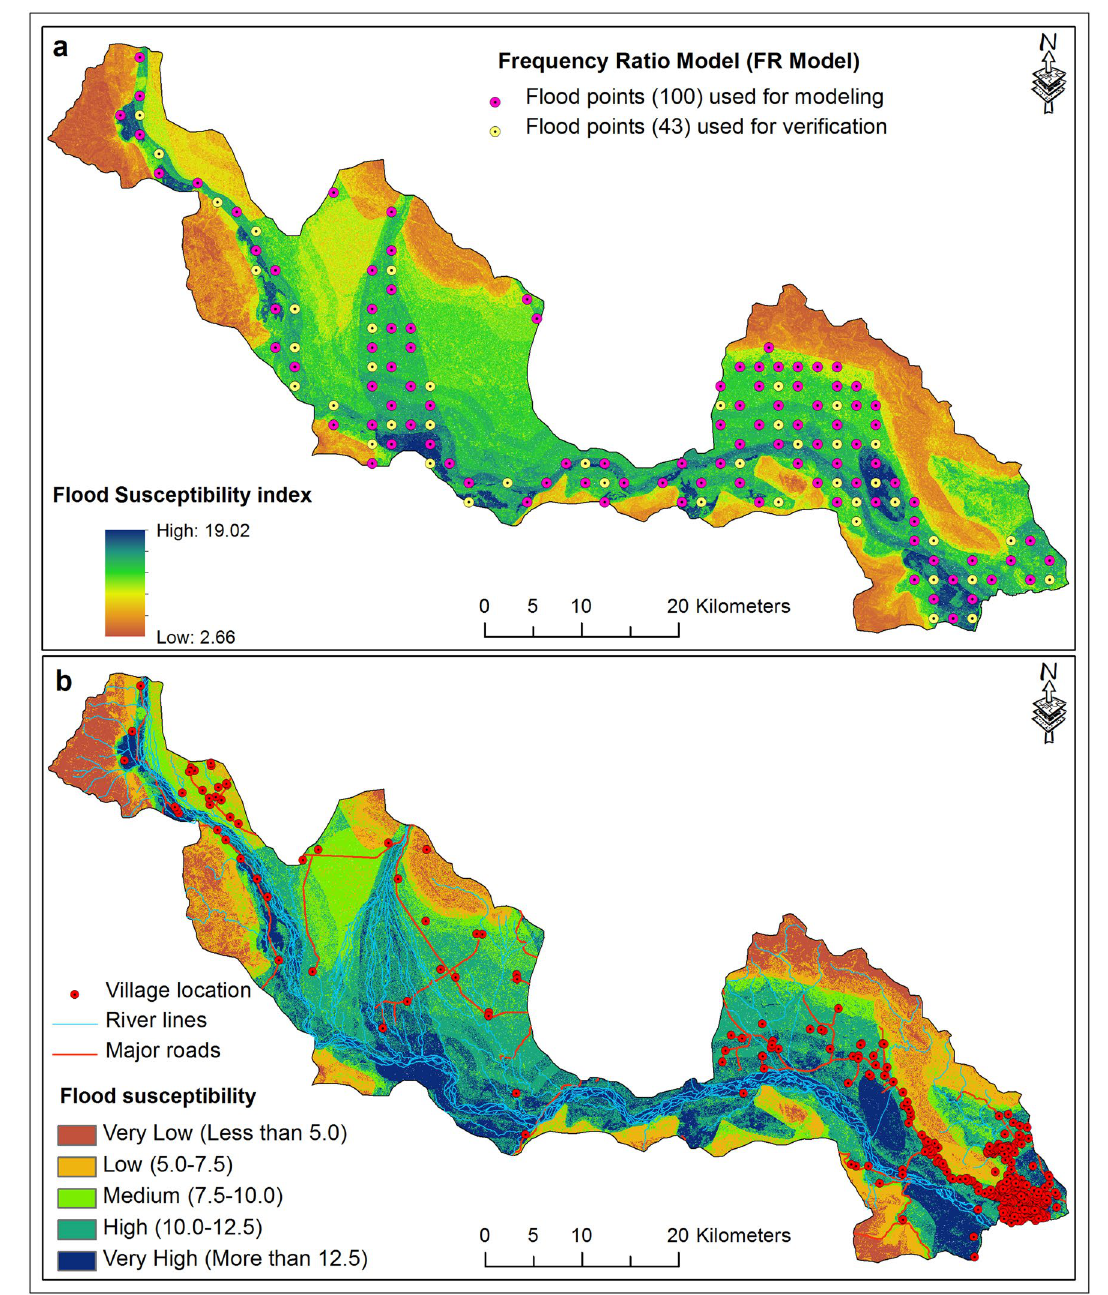
Fig. 4 Output map through FR model: ( a ) flood susceptibility index with all flood points and ( b ) overlay of villages and road on flood suscepti- bility